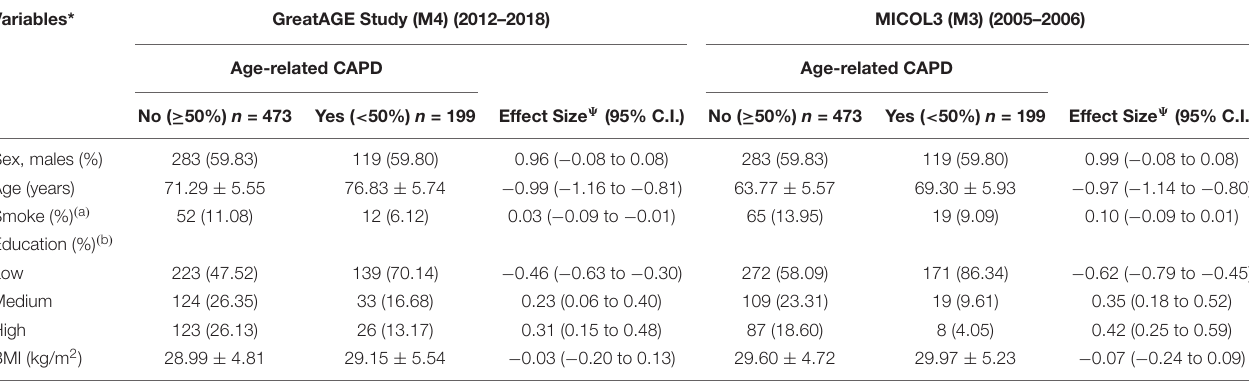
TABLE 1 | Sociodemographic and clinical characteristics of the population of the GreatAGE Study examination (M4) and about 12 years back in time of the MICOL3 examination (M3) ( n = 734, non-age-related CAPD n = 473, age-related CAPD n = 199, missing n = 62).